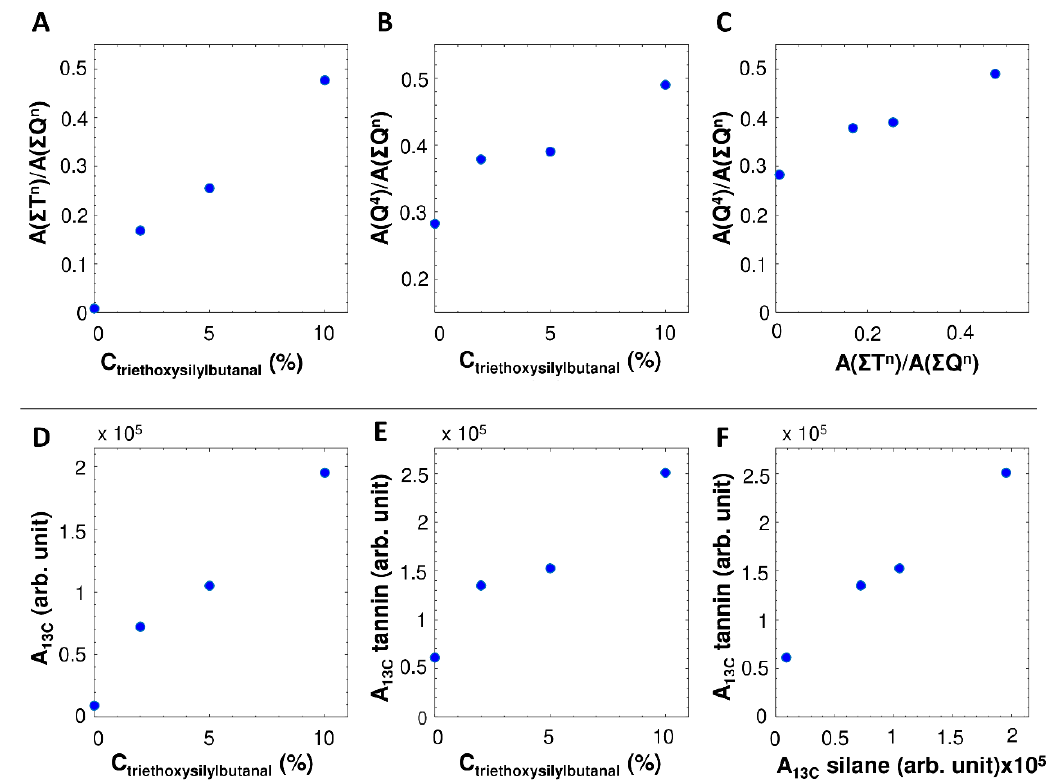
Figure 4. Integrated 1 H- 29 Si CP MAS NMR ( A – C ) and 1 H- 13 C CP MAS NMR ( D – F ) peak areas. ( A ) Increase in T n peak area ( − 50 to − 80 ppm) with increasing trialkoxysilane concentration. ( B ) Increase in silica polymerization (Q 4 peak area, see Figure S6) with increasing trialkoxysilane concentration. ( C ) Increase in silica polymerization with increasing T n peak area. ( D ) Increase in intensity of the silane peak area (5 to 22 ppm) with increasing trialkoxysilane concentration. ( E ) Increase in tannin peak area (60 to 162 ppm) with increasing trialkoxysilane concentration. ( F ) Correlation between the tannin and silane peak intensities.